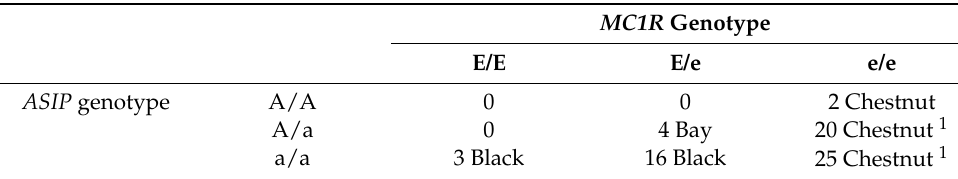
Table 3. Combined distribution of MC1R and ASIP loci genotypes and base coat color phenotypes of the 70 genotyped Sarcidano